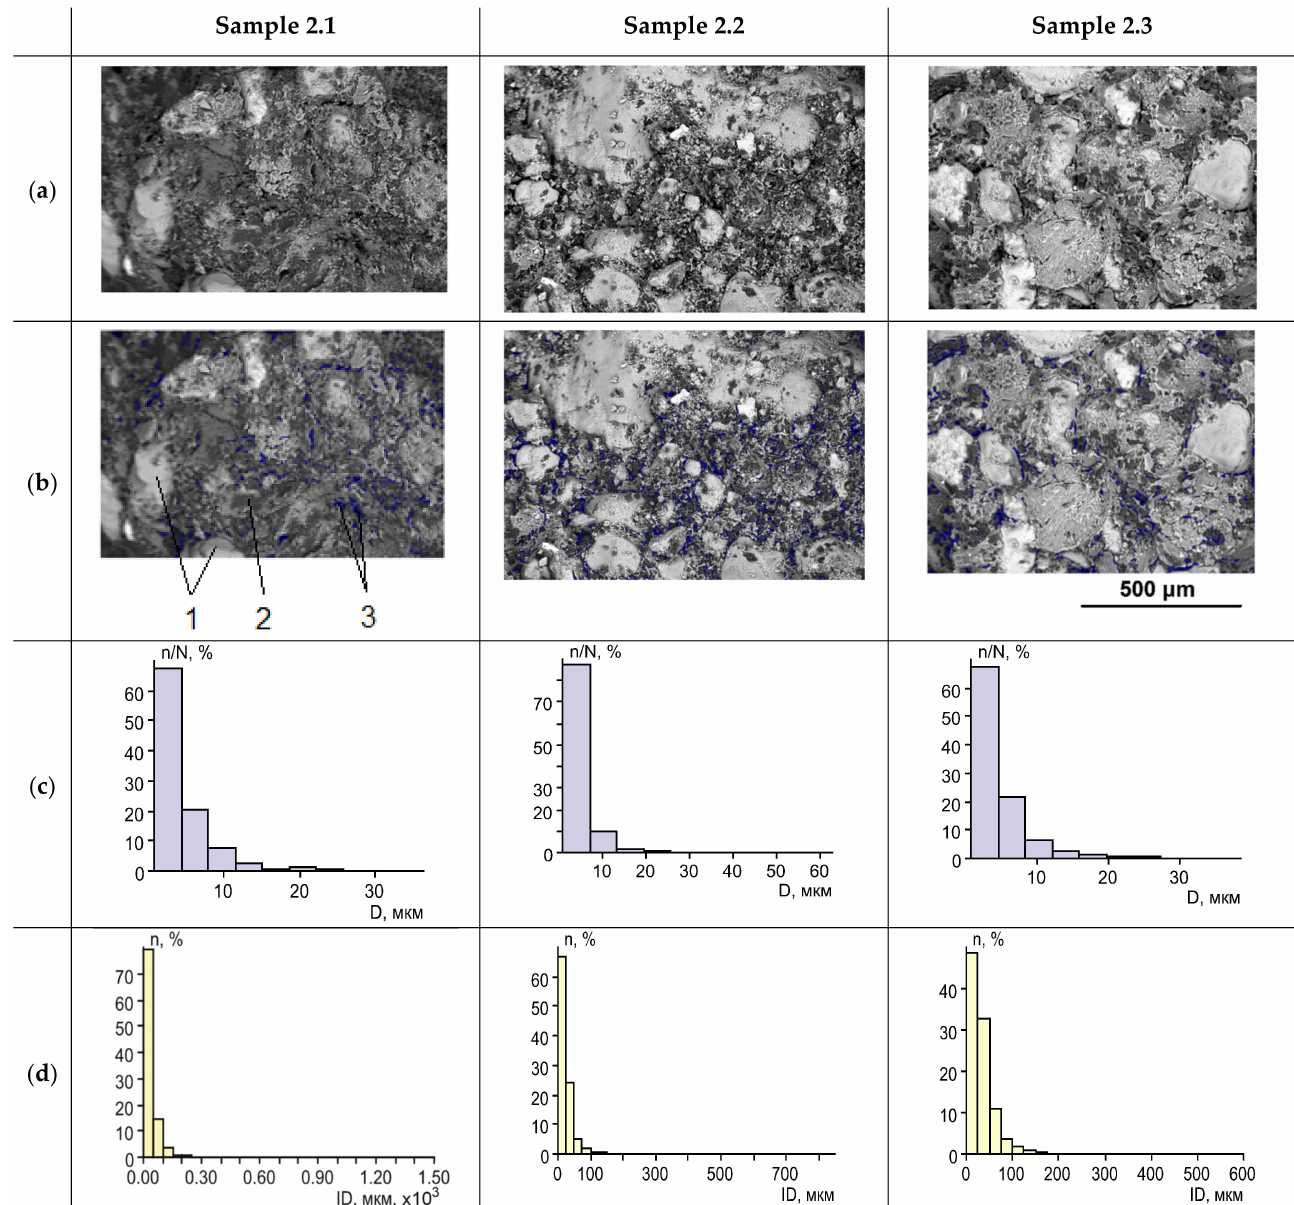
Figure 7. The structure of the sand reinforced by the injection of a prepared two-component silicate resin solution: ( a ) Backscattered electron images of the samples; ( b ) samples with highlighted inter-grain voids: 1—sand grains; 2—aggregates of cured polymer resin; 3—voids; ( c ) distribution histogram of the void sizes (D—diameter); ( d ) distribution of inter-void